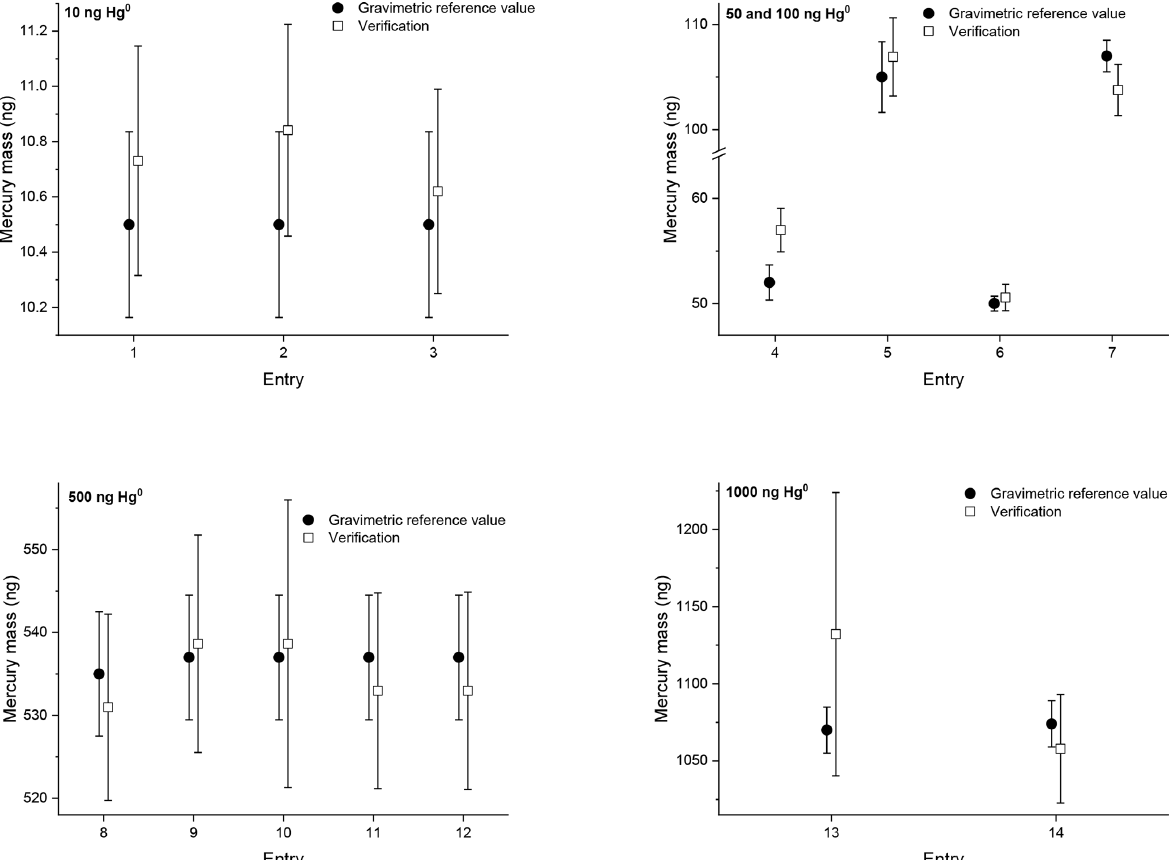
Figure 2. Verification results of the second comparison with mercury amounts of approximately 10, 50, 100, 500 and 1000ng on sorbent tubes. The open squares are the verification results. The closed circles are the reference values determined gravimetrically. The error bars indicate the expanded uncertainty for the reference value (ng) ( k = 2) and the verification value (ng) ( k =